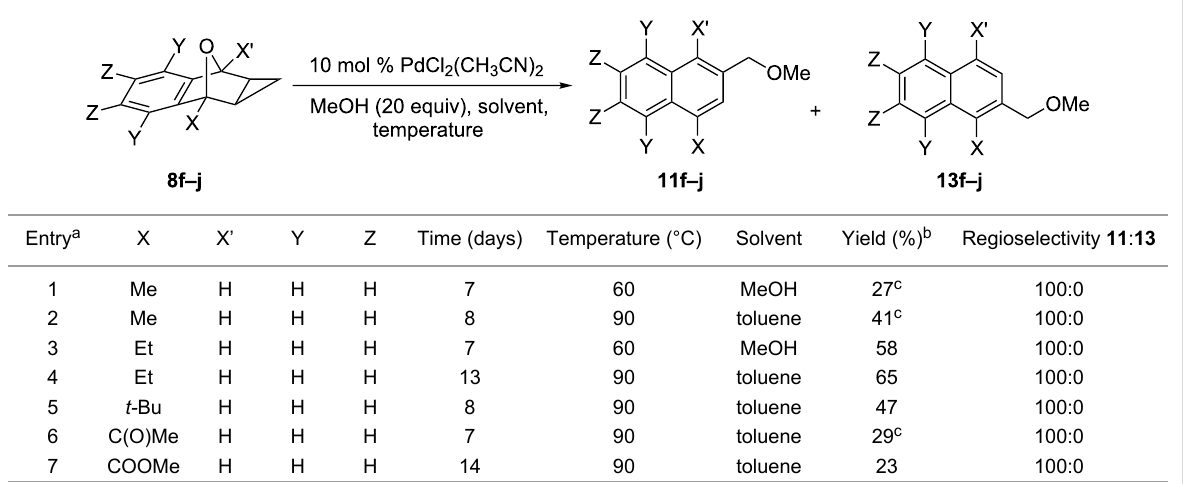
Table 4: Scope of the reaction with unsymmetrical substituted cyclopropanated 7-oxabenzonorbornadiene.